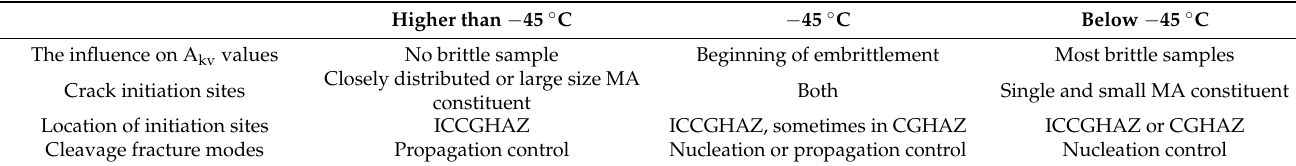
Figure 10. ( a ) The schematic diagram of the three stages of the cleavage fracture; ( b ) The normal stress as a function of the distance from the notch tip at different temperatures. σ yy –the normal stress; σ max –the maximum normal stress; σ pm –the stress at the Particle/Matrix interface; σ mm –the stress at PAGB; DMS–the distance of maximum stress. Table 4. The concluded results of the influence of ICCGHAZ on the overall